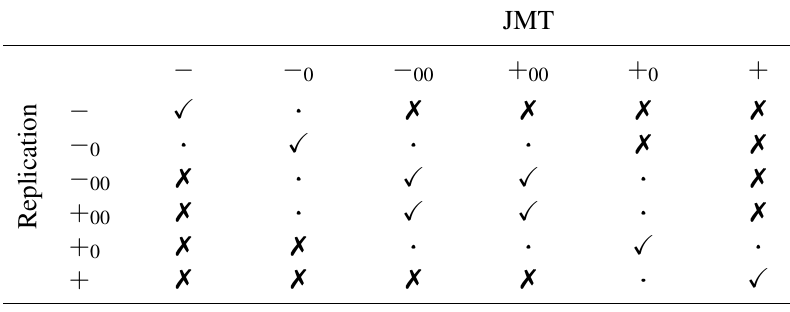
coefficient, − a negative one. The subscript ’0’ indicates an absolute t -ratio between 1.6 and 2, ’00’ indicates one lower than 1.6. The absence of a subscript indicates an absolute t -ratio > 2. Table 3: Classification of the replication